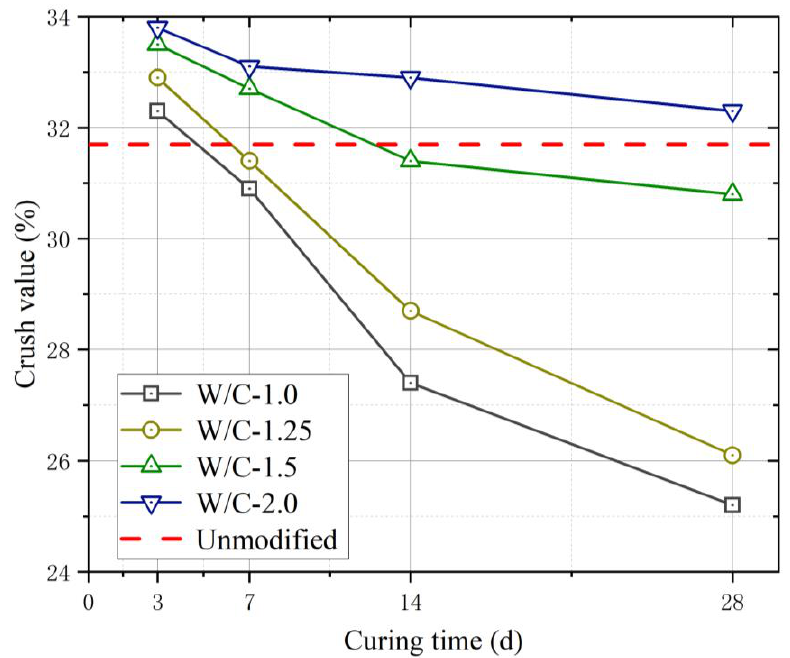
Figure 7. C r of coral aggregates modified by slurry of different W/C values.